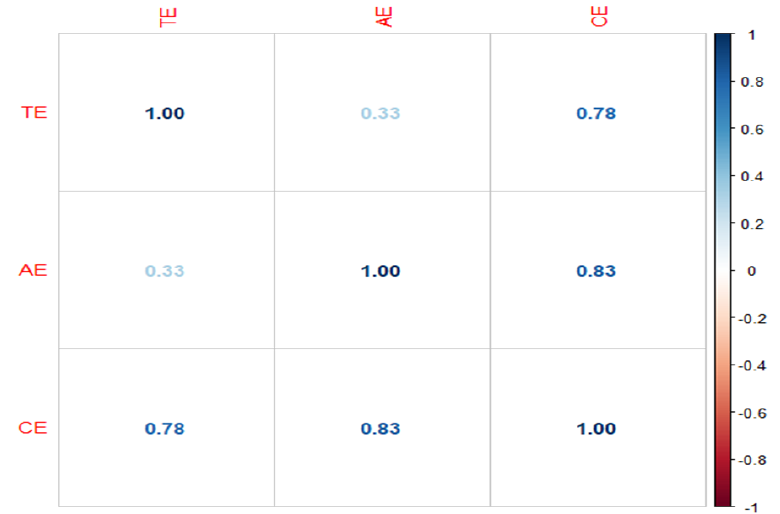
Figure 3. Correlations for efficiency